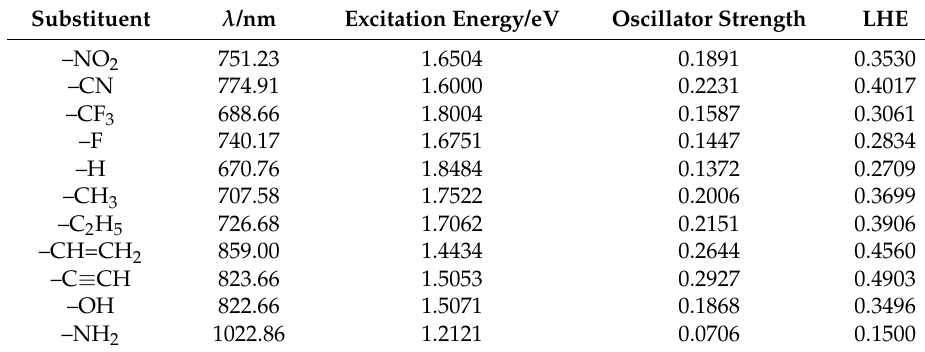
Table 3. The maximum absorption wavelength of Ni(S 2 C 2 R 2 ) 2 . (R=–NO 2 , –CN, –CF 3 , –F, –H, –CH 3